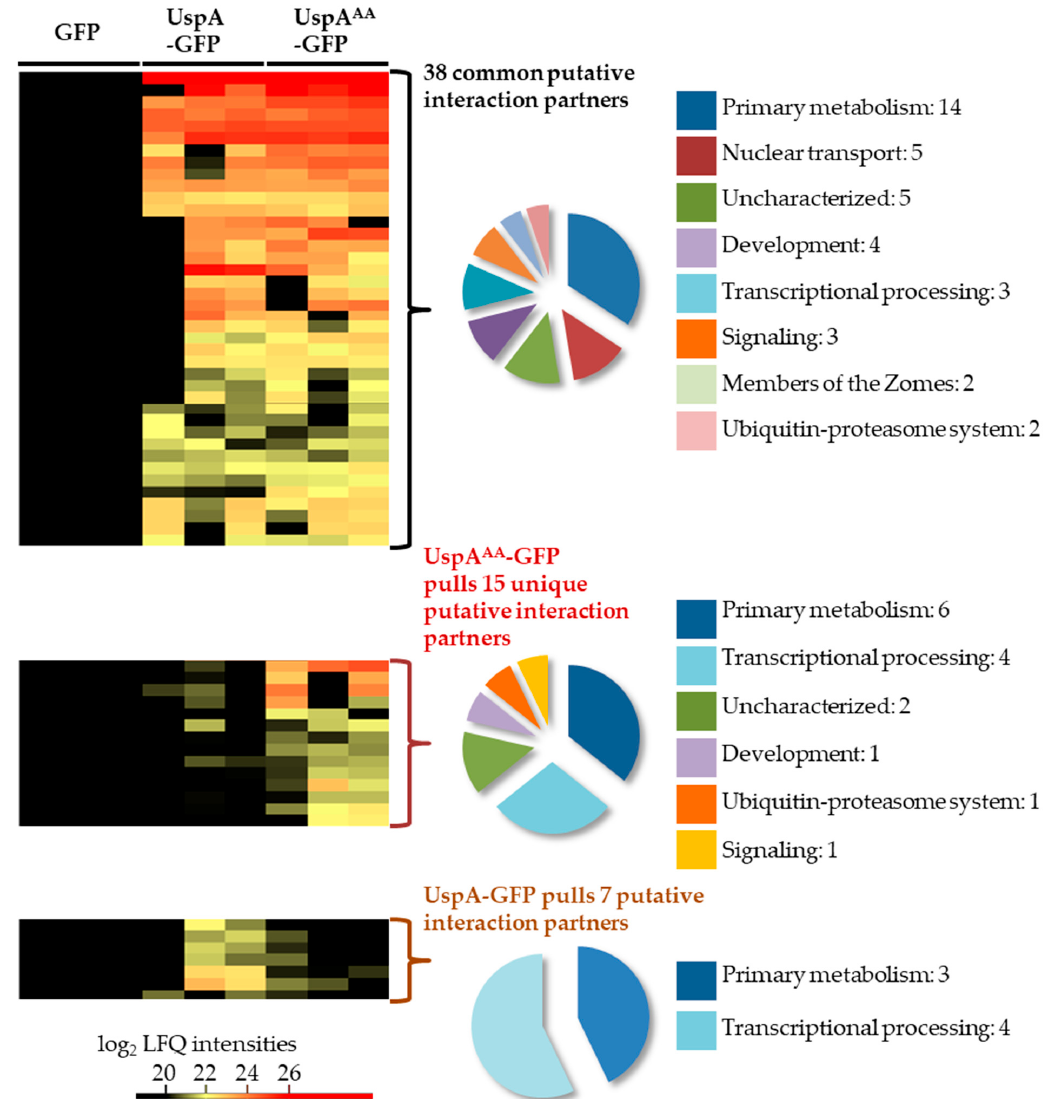
Figure 3. UspA-GFP pull-downs captured proteins related to primary metabolism, nuclear transport, and transcriptional processing. GFP pull-down experiments were performed with A. nidulans strains expressing either functional UspA-GFP protein, or the inactive UspA AA -GFP mutant or mere GFP as a negative control. The cultures were inoculated with 10 6 spores/mL in minimal medium and were grown for 20 h vegetatively at 37 °C in the presence of light. Elution fractions were analyzed with LC-MS, and putative interaction partners of UspA-GFP, UspA AA -GFP are shown in the heat map. The heat map represents the log2 of the label-free quantification (LFQ) values of the co-purified proteins. Identified proteins were assigned into different categories that are represented in pie charts.